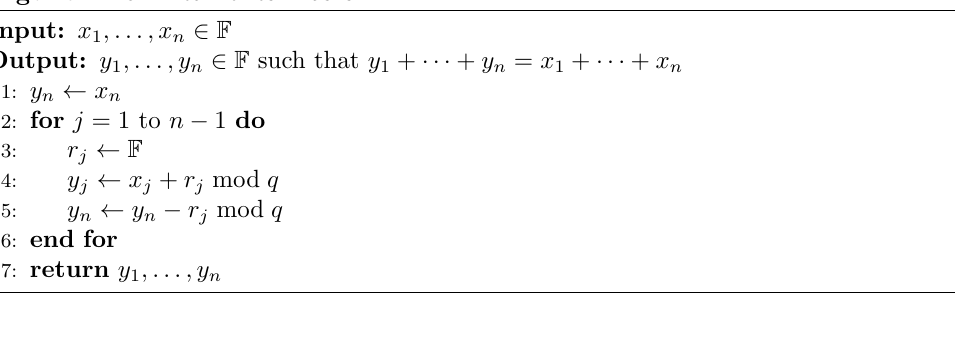
Algorithm 10 RecombineShares